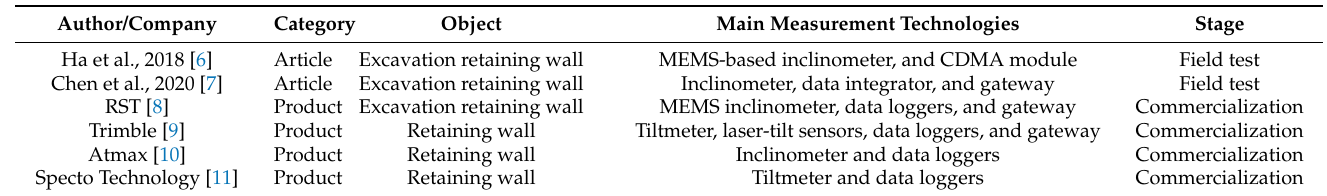
Table 1. Previous studies related to retaining wall displacement measurement using contact measure- ment methods.